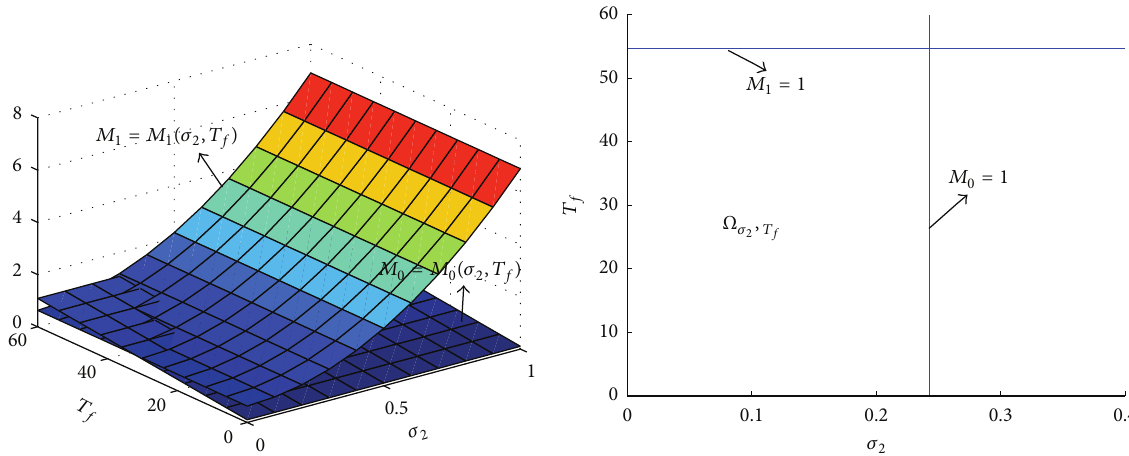
Figure 6: The positive equilibrium 𝐸 ∗ is stochastically stable provided that (𝜎 2 , 𝑇 𝑓 ) ∈ Ω 𝜎